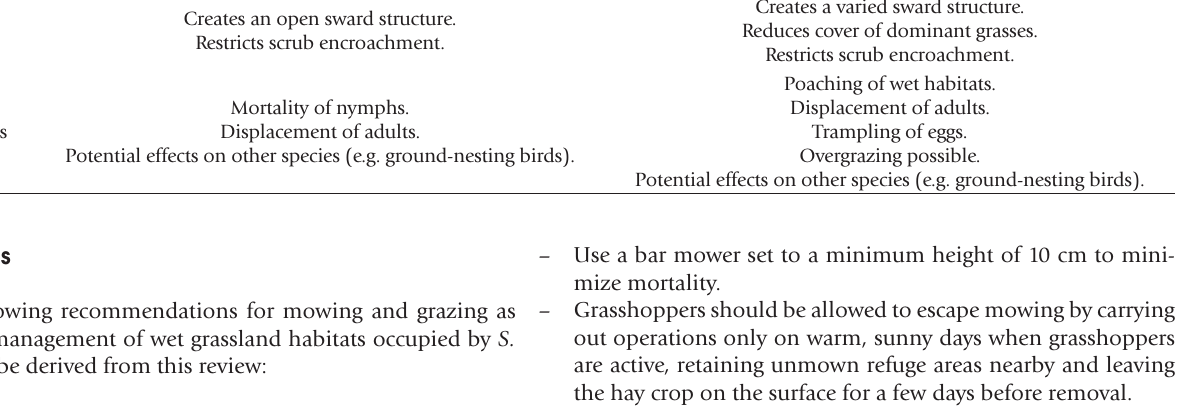
Table 2. Advantages and disadvantages of mowing and grazing for S. grossum.